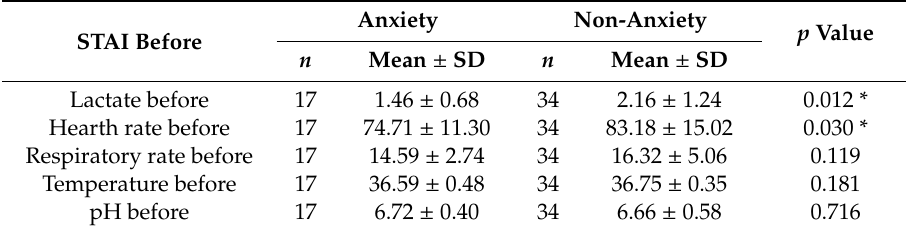
* Statistically significant di ff erences. SD, Standard